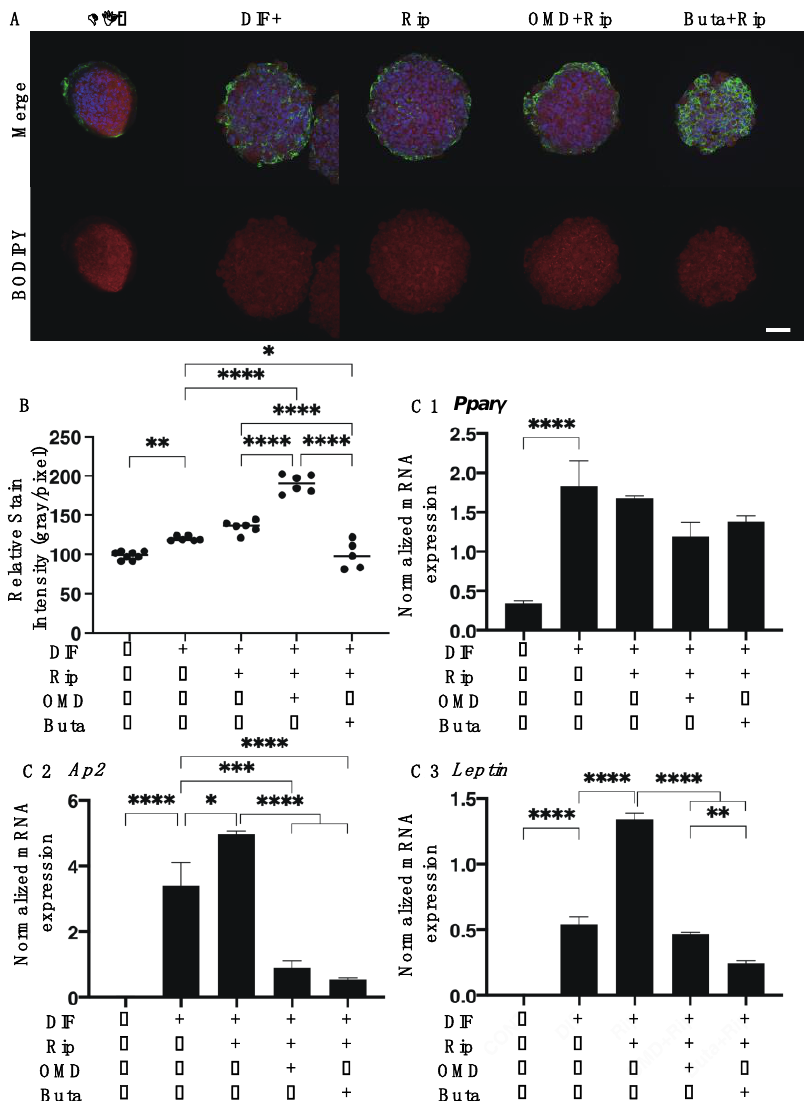
Figure 5. Additive effects of EP2 agonists to ripasudil (Rip) on the adipogenesis of 3T3-L1 3D organoids. The 3D organoids of 3T3-L1 cells were prepared under several sets of conditions: preadipocytes of 3T3-L1 cells (DIF-) or adipogenic differentiation (DIF+) with or without a combination of 10 µ M ripasudil (Rip) and the EP2 agonist, 100 nM omidenepag (OMD) or 100 nM butaprost (Buta). These samples were immunostained with DAPI (blue), phalloidin (green) and BODIPY (red). Merge images and BODIPY images are shown in panel A (scale bar: 100 µ m) and their staining intensities (gray/pixel) were plotted (panel B ). The expression of the mRNA of adipogenesis-related genes including Ppar γ , Ap2 and Leptin under the above conditions were plotted and the data are shown in panel C 1–3. All experiments were performed in duplicate using fresh preparations, each consisting of 16 organoids. Data are presented as the arithmetic mean ± the standard error of the mean (SEM). * p < 0.05, ** p < 0.01, *** p < 0.005, **** p < 0.001 (ANOVA followed by a Tukey’s multiple comparison